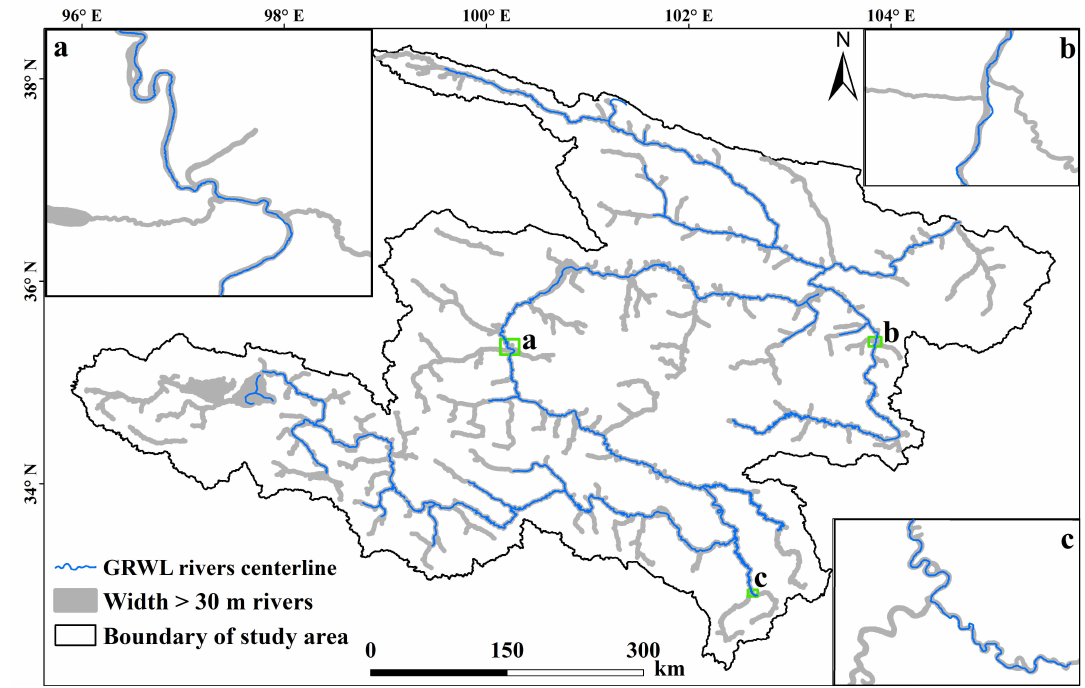
Figure 7. Comparison of the extraction results of connected rivers (width > 30 m) and the GRWL centerline products. GRWL are the global river widths from Landsat by Allen and Pavelsky. Width > 30 m rivers are the extraction results of connected rivers from Sentinel-2 images in the study